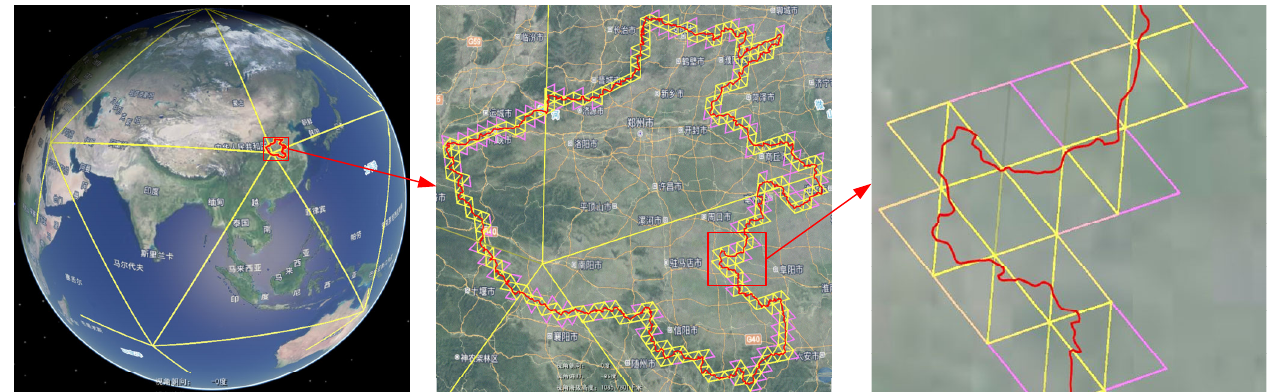
Figure 12. The ninth level HtoTcode discrete line.